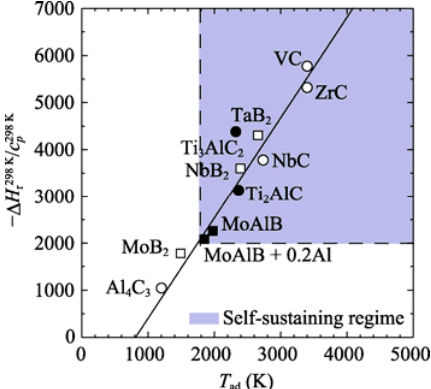
Fig. 7 Enthalpy–temperature SHS analysis of Reaction (1) (Mo + (1 + y )Al + B = MoAlB + y Al). ABCD and A ’ B ’ C ’ D ’ represent calculation processes of adiabatic temperature from 1Mo/1Al/1B precursors at room temperature and preheated to 400 K, respectively.